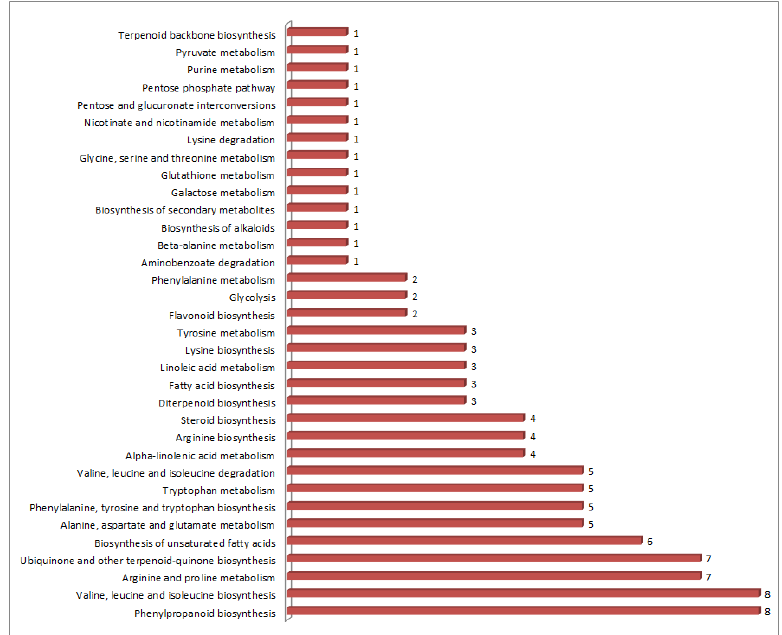
Figure 3. Mapping of 113 different metabolites belonging to 21 different classes against 34 sub-pathways listed in KEGG (Kyoto Encyclopaedia of Genes and Genomes). Values indicate the number of metabolites mapped against the respective pathway.